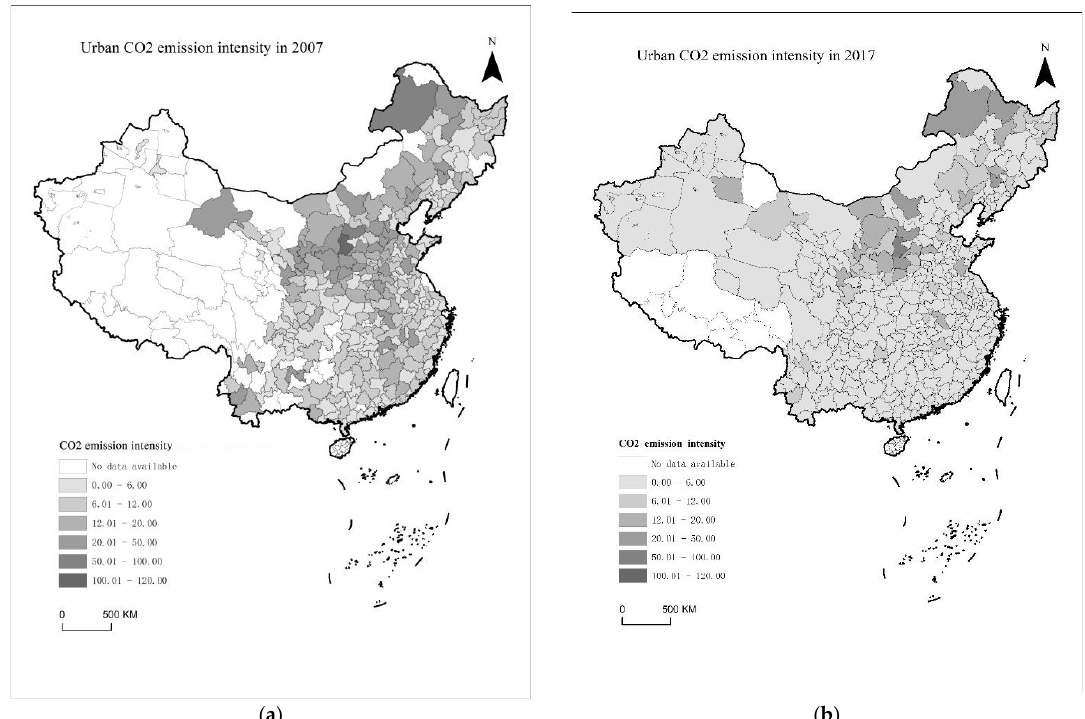
Figure 6. Spatial evolution of CO2 emission intensity (2007 – 2017). Note. The analysis unit is the national prefecture-level administrative